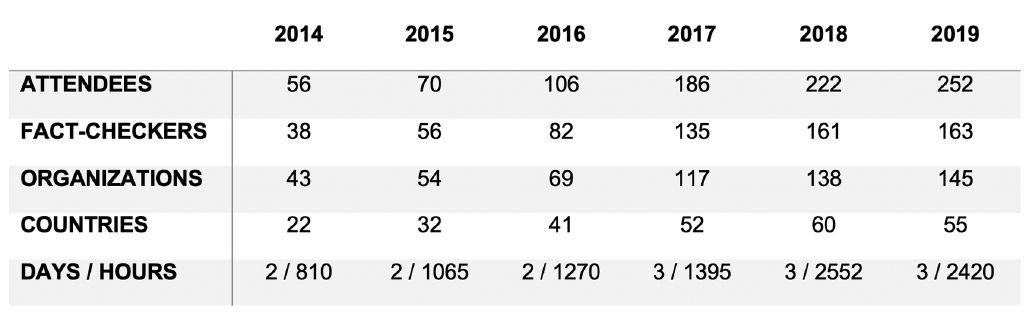
Table 1: Growth of Global